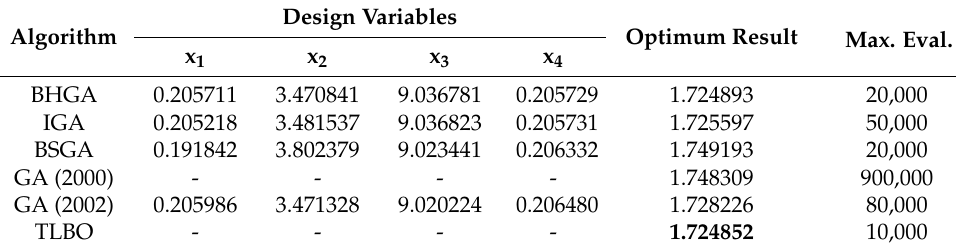
Table 8. Comparison of the BHGA optimization results with literature for the welded beam problem.